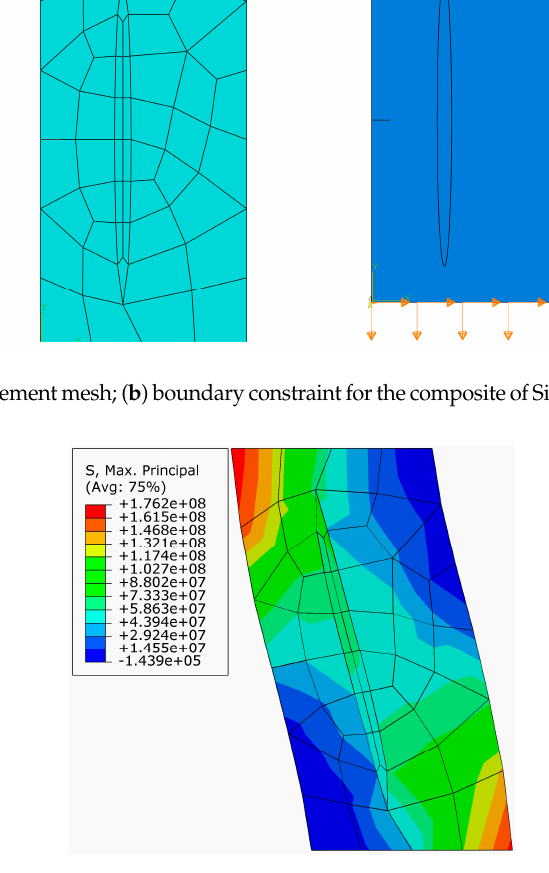
Figure 12. Predicted maximum principal stress distribution at the onset of crack propagation for the SiC fiber-reinforced Ti 3 SiC 2 composites.